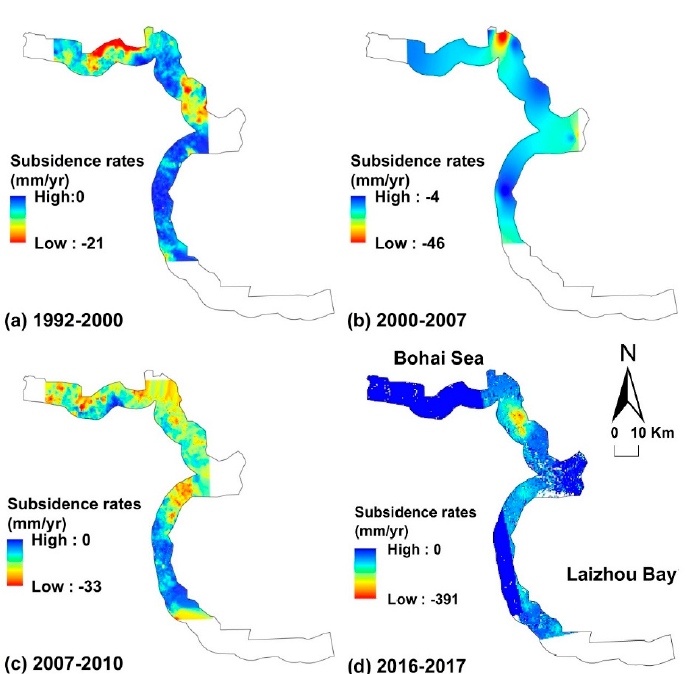
Figure 2. Land subsidence rate maps (( a , c , d ,) derived from InSAR; ( b ) geodetic leveling) [11,13].